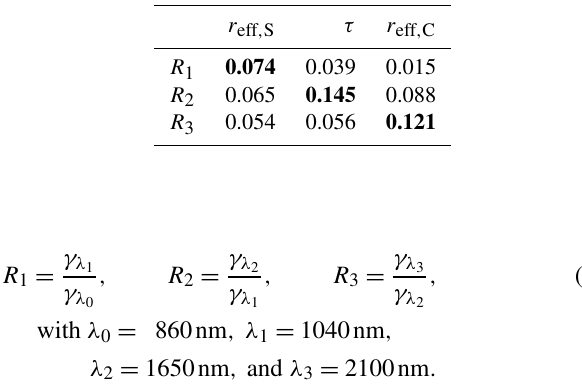
Table 1. Standard deviation of the reflectivity ratios R 1 , R 2 , and R 3 with respect to one of the three cloud and snow parameters τ , r eff , C , and r eff , S . r eff , S τ r eff , C R 1 0.074 0.039